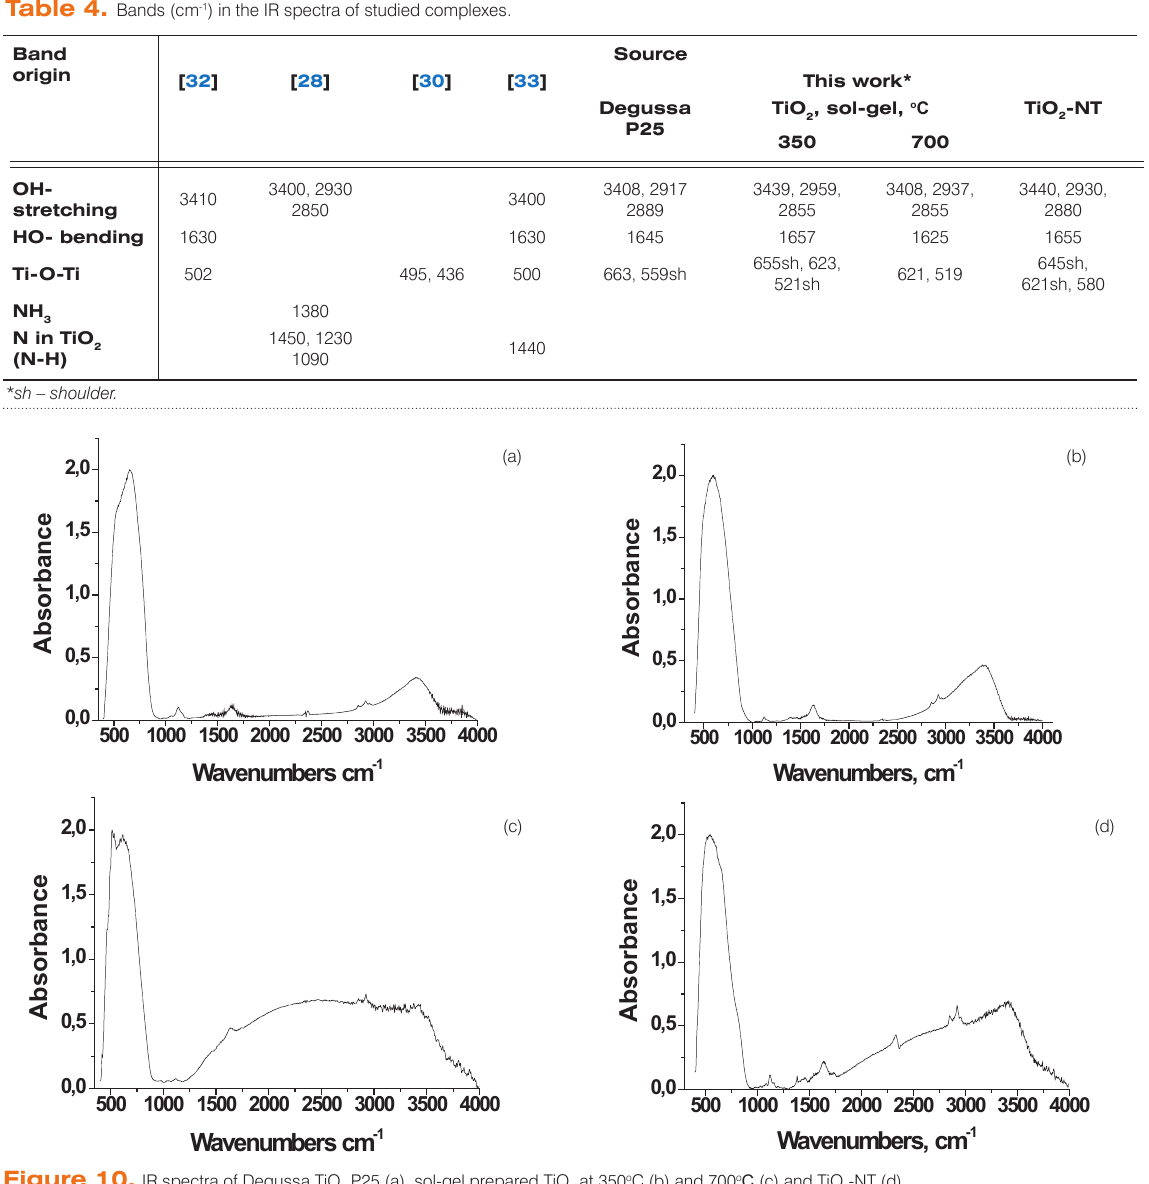
P25 (a), sol-gel prepared TiO 2